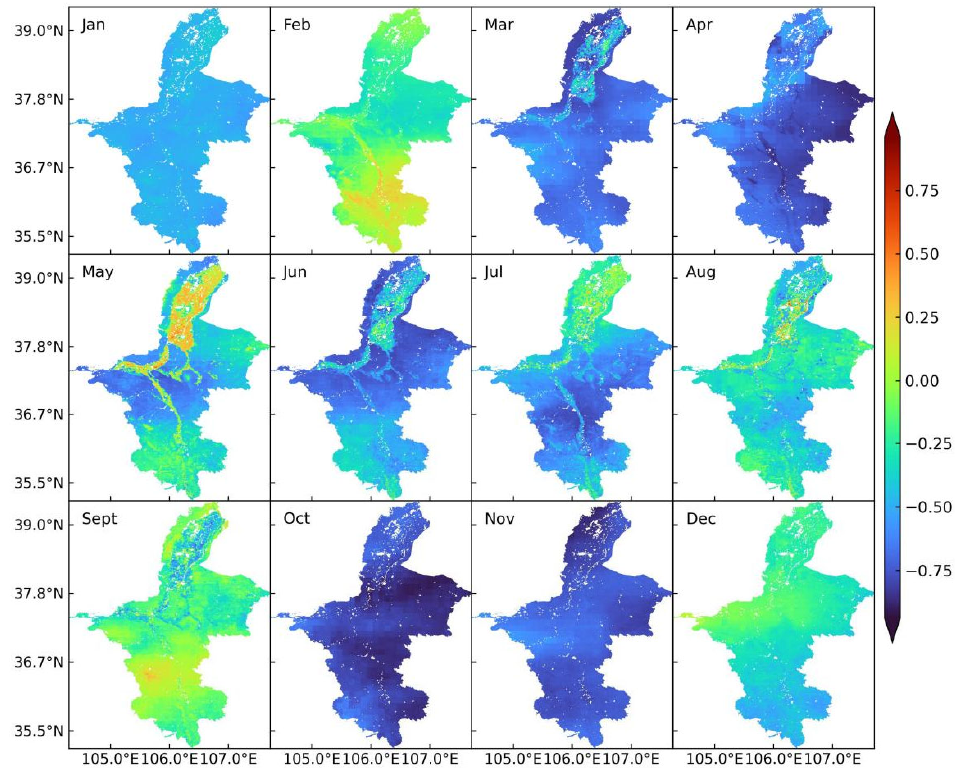
Figure 12. Spatial distribution of the correlation coefficient between EDI and precipitation.